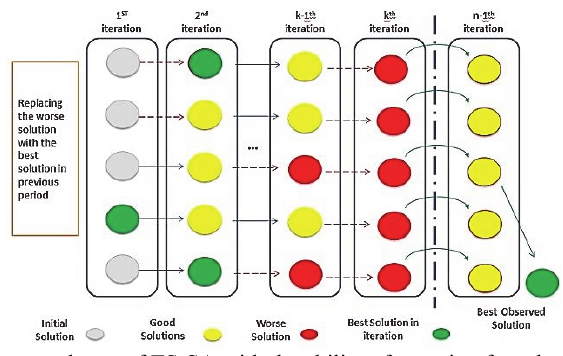
1 Fig. 6. Solving process scheme of TS-SA with the ability of escaping from local optimum traps